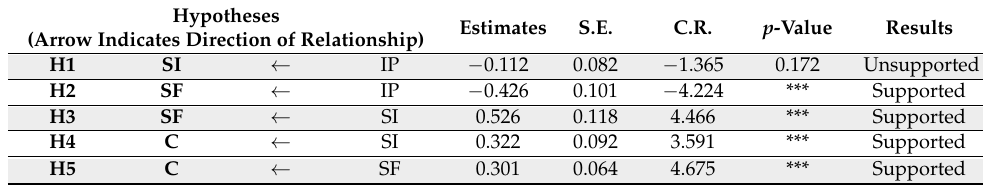
Table 7. Hypotheses testing